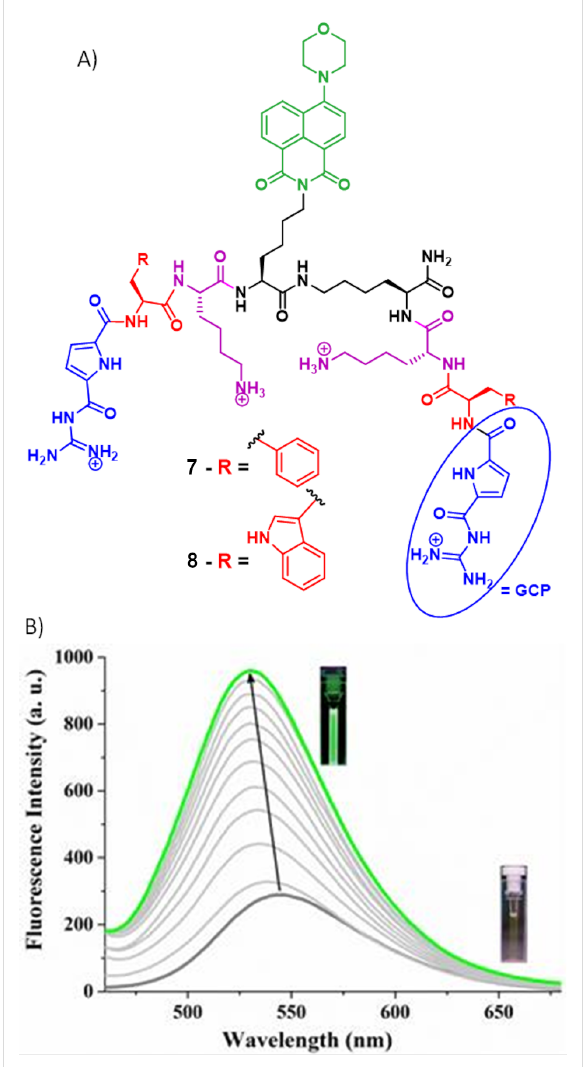
Figure 7: A) Molecular structure of peptidic probes 7 and 8 ; B) fluores- cence emission spectra of probe 7 (5.0 µM) with increasing concentra- tion (0–5.0 µM) of 14-3-3 β protein ( λ ex = 410 nm). Inset: Correspond- ing fluorescence color of the solution inside cuvette under UV lamp. Reproduced from [47] with permission from The Royal Society of